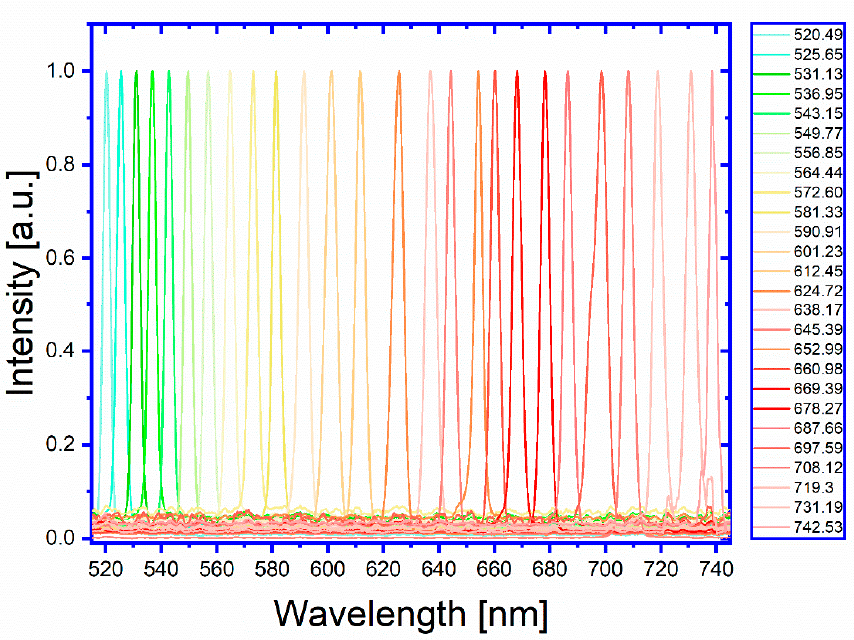
Figure 4. The resultant SFG spectrum. The spectrum shows the demonstrated tuning range of sum-frequency generation from 520.5 to 742.5 nm with normalized cross-correlation intensity measurements using a spectrometer HR4000 (Ocean Optics) as a detector.